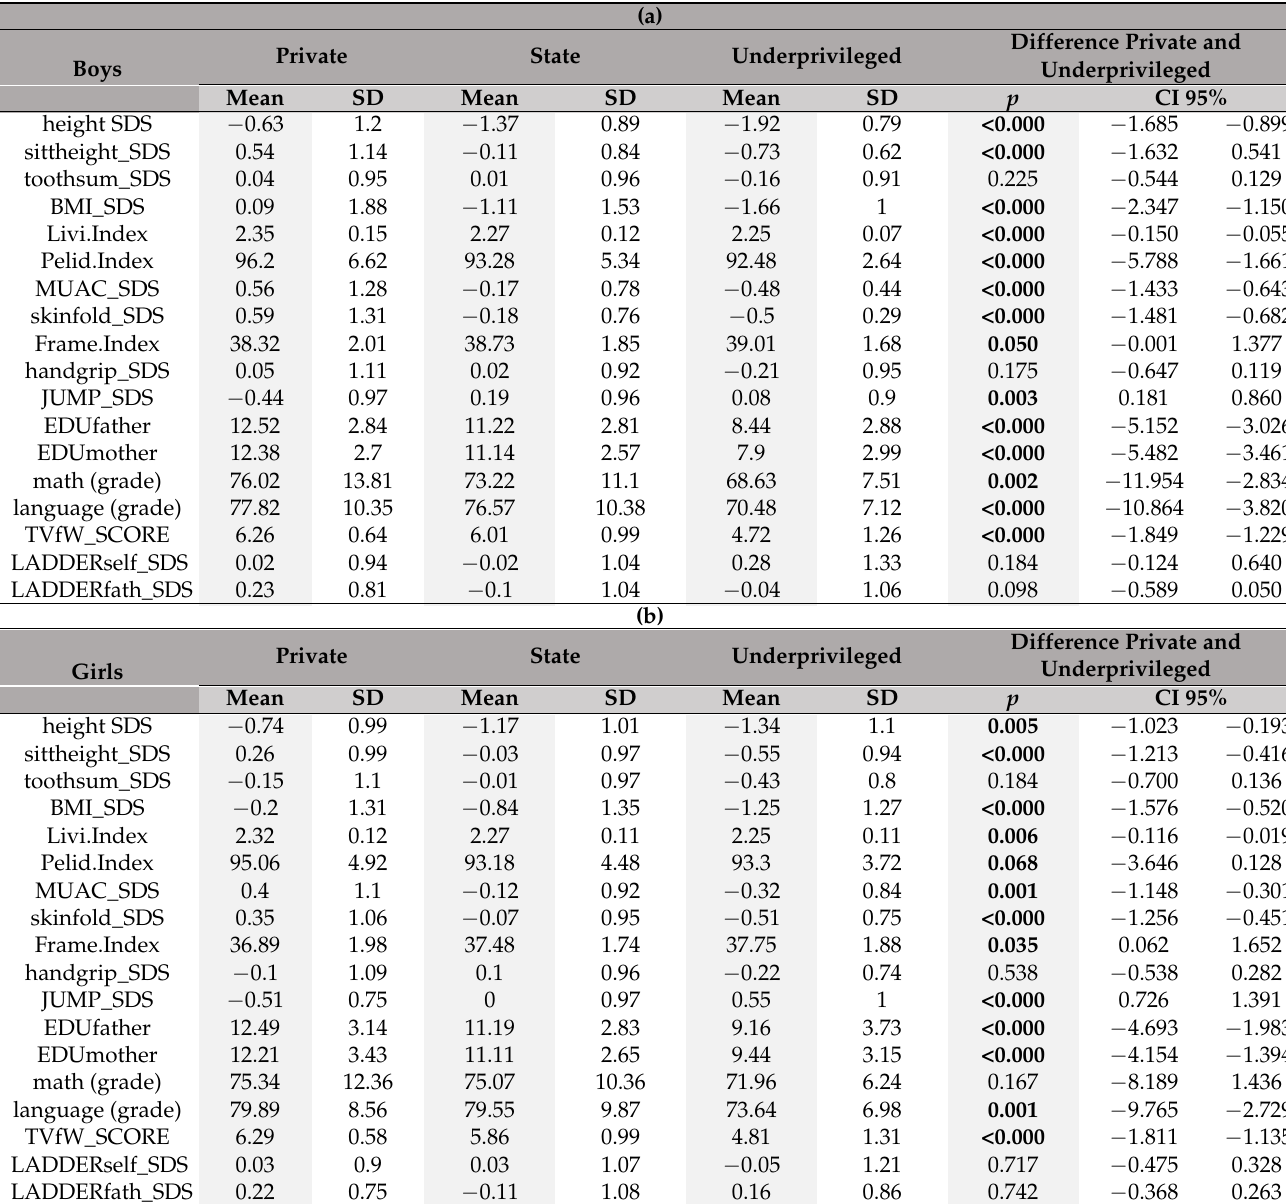
Table 1. ( a ) Descriptive statistics (mean, SD) boys of private school ( n = 104, state schools ( n = 222), underprivileged school ( n = 43) and ( b ) girls of private school ( n = 92), state schools ( n = 230), underprivileged school ( n = 32) in Kupang (West-Timor). Significant p -values ( p ≤ 0.05) of the differences between private and underprivileged school children are indicated by bold letters, 95% confidence interval are added (CI